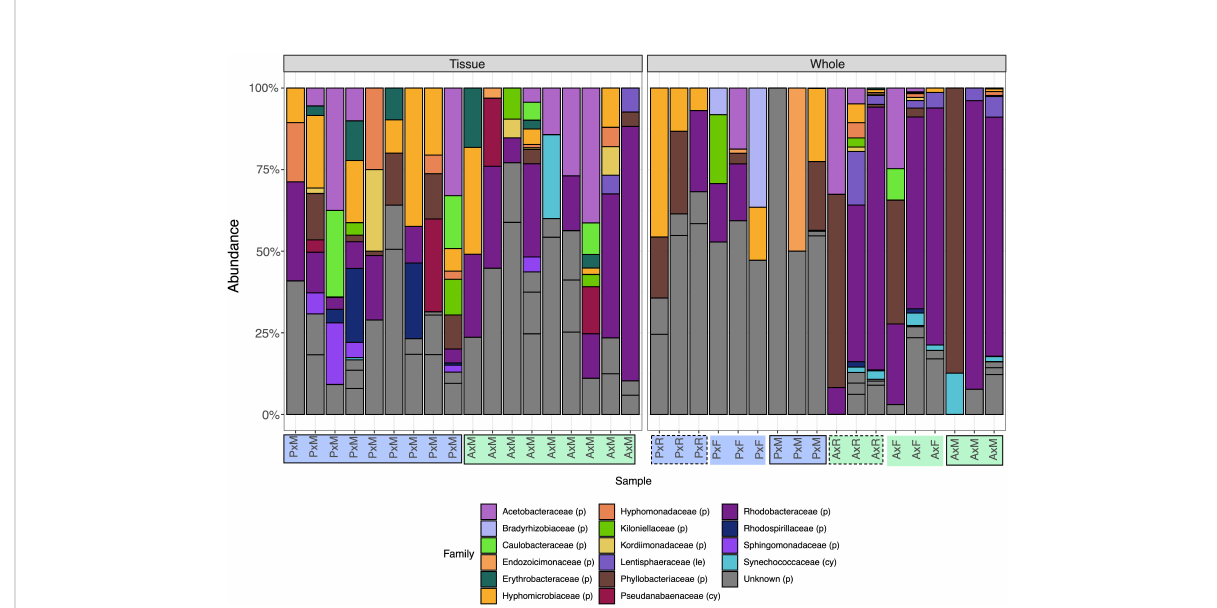
FIGURE 2 Relative abundance of the top 20 bacterial families present in samples from three protocols (M/solid border: Micro, R/dashed border: RecoverAll, F/no border: FFPE), two coral genera (P/blue: Pocillopora, A/green: Acropora), and two sample types (Tissue and Whole). Extractions on tissue biopsies were only successful using the Micro protocol, whereas extractions on whole fragments were successful using the RecoverAll, FFPE, and Micro protocols. Species that had the same taxonomy at the family level were merged using the tax_glom function in phyloseq. Four groups could not be resolved to the family level ( “ Unknown ” ) and are represented as distinct ASVs by subdivisions of grey columns. Phylum is indicated by either (p): Proteobacteria, (le): Lentisphaerae, or (cy):